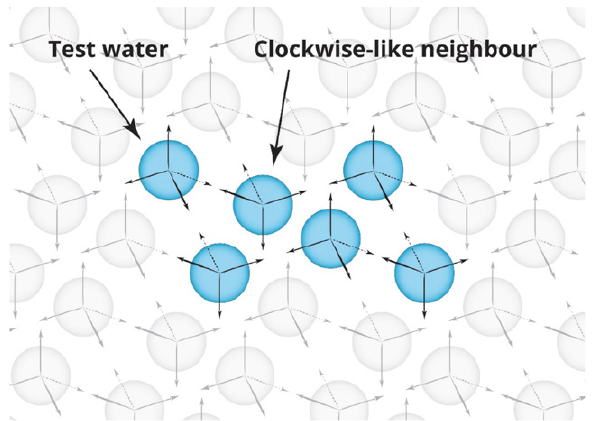
Figure 5: Lattice of the model showing both the hexagon of the ice- like structure and a pair interaction used for bookkeeping to avoid triple counting. Presented is only one